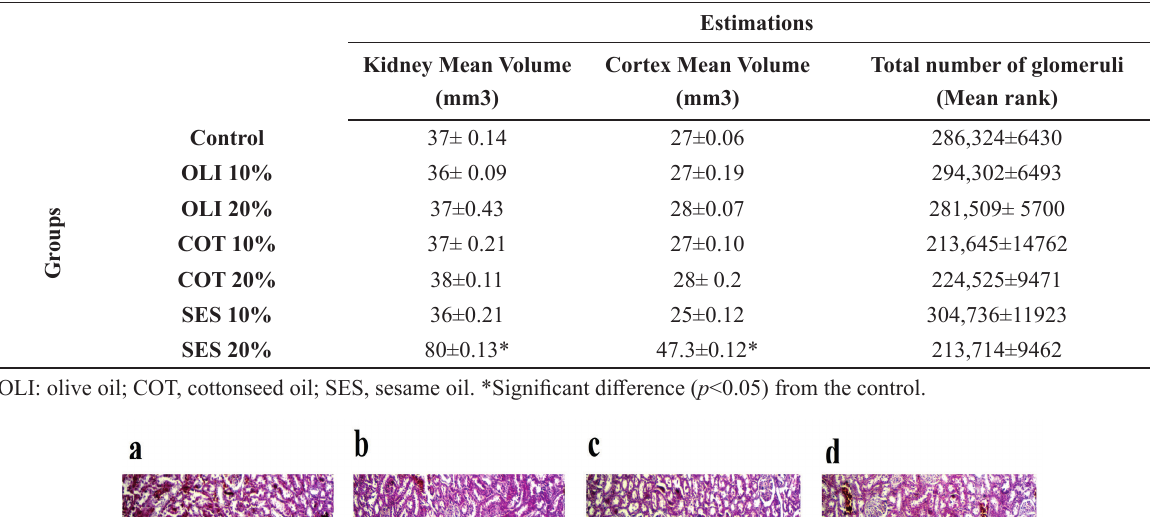
Mean volumes of the kidney and cortex and total glomeruli number.